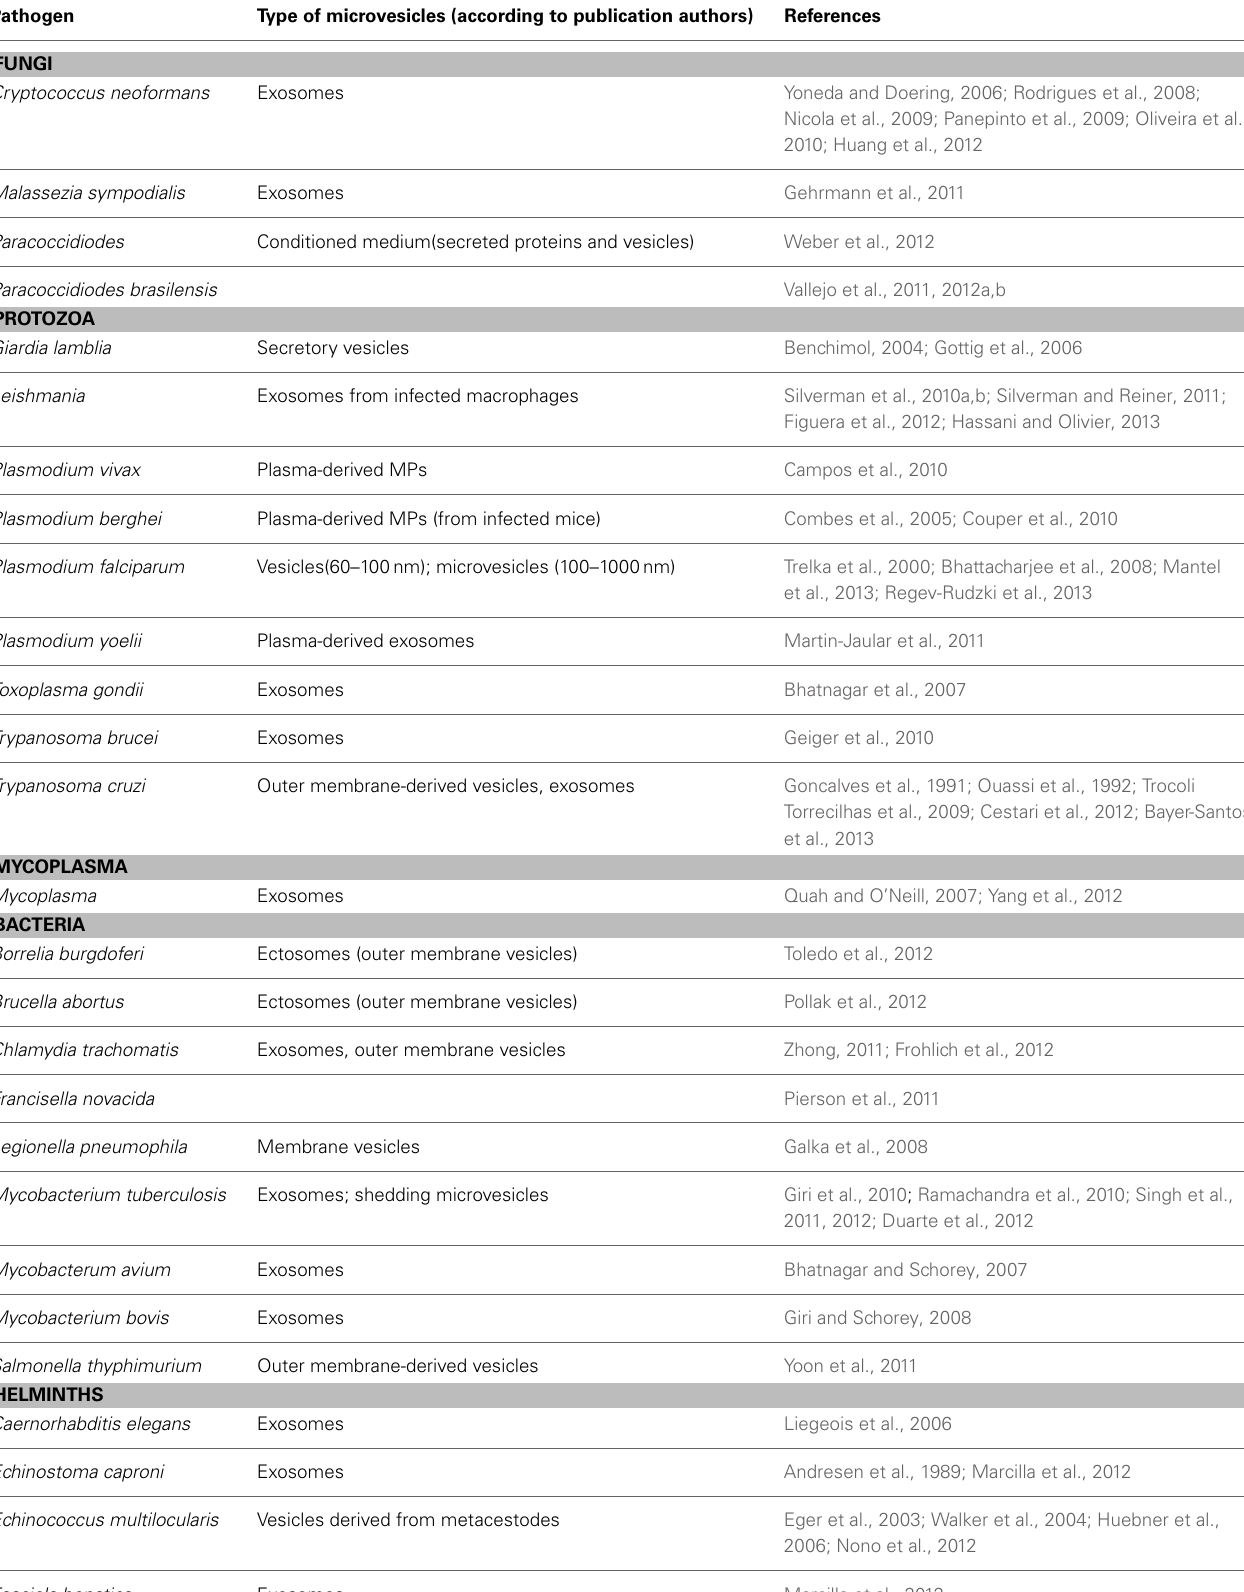
Table 1 | Microvesicles produced in response to different parasitic